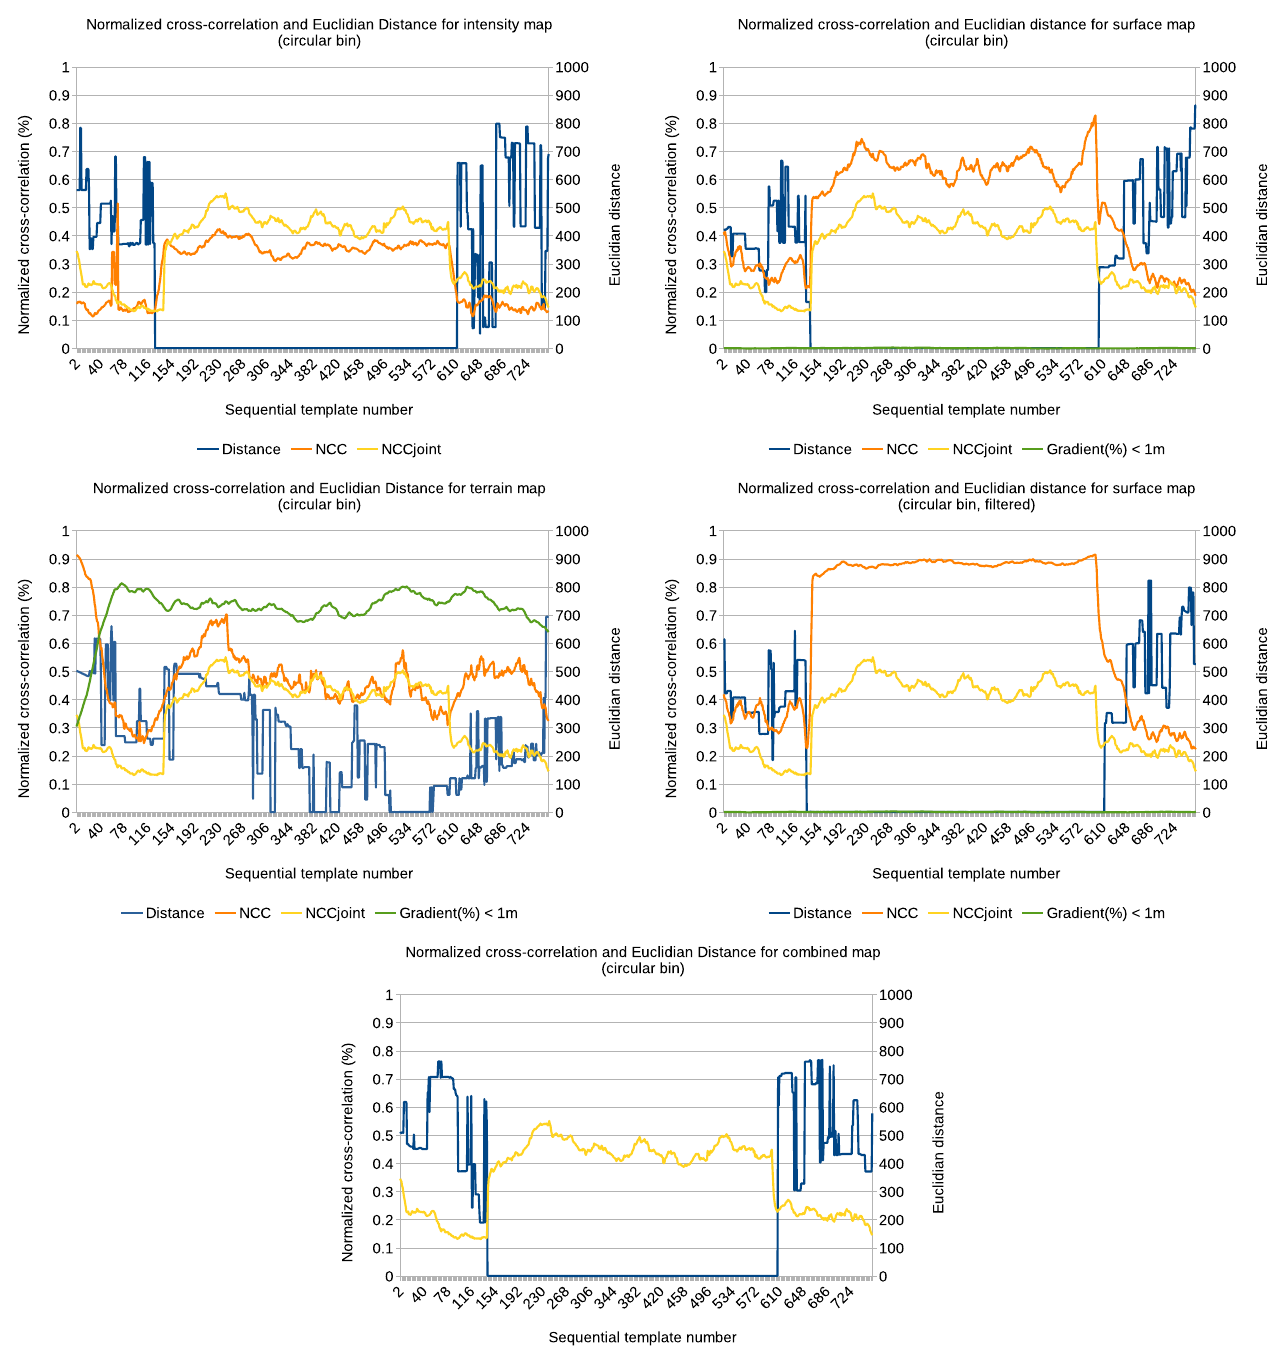
Figure 14. Matching results of intensity, surface, terrain, filtered surface and combined approaches. Circular binning was utilized. NCC joint was replicated on the other graphs for facilitated comparison. For further analysis, template indexes from 146 to 600 were selected and the root mean square errors of Cross-correlation and Normalized Cross-correlation were calculated and are compared on Table 2. Those indexes were conservatively chosen because they lie completely inside the area covered by the reference database. Therefore, any remaining errors and mismatches are caused by incorrect position estimation of the template matching algorithm and not due to missing reference